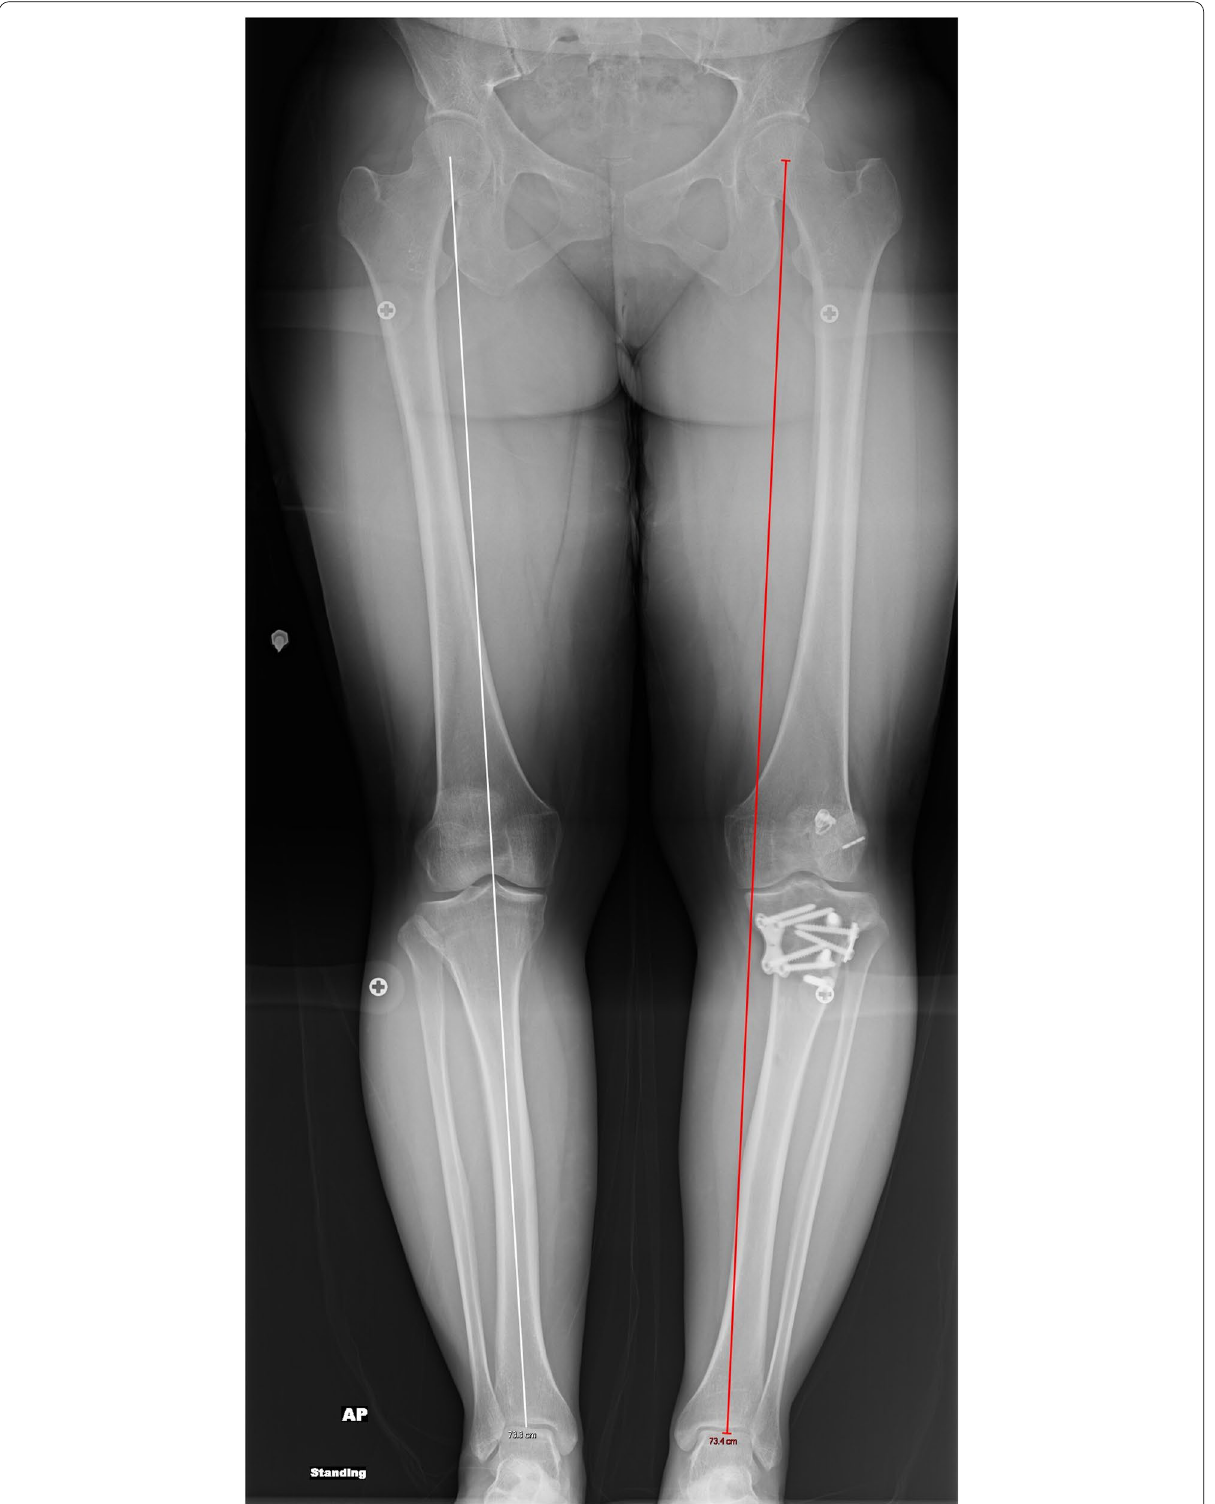
Fig. 4 A post-operative standing mechanical axis radiograph demonstrating varus malunion of the anterior closing wedge